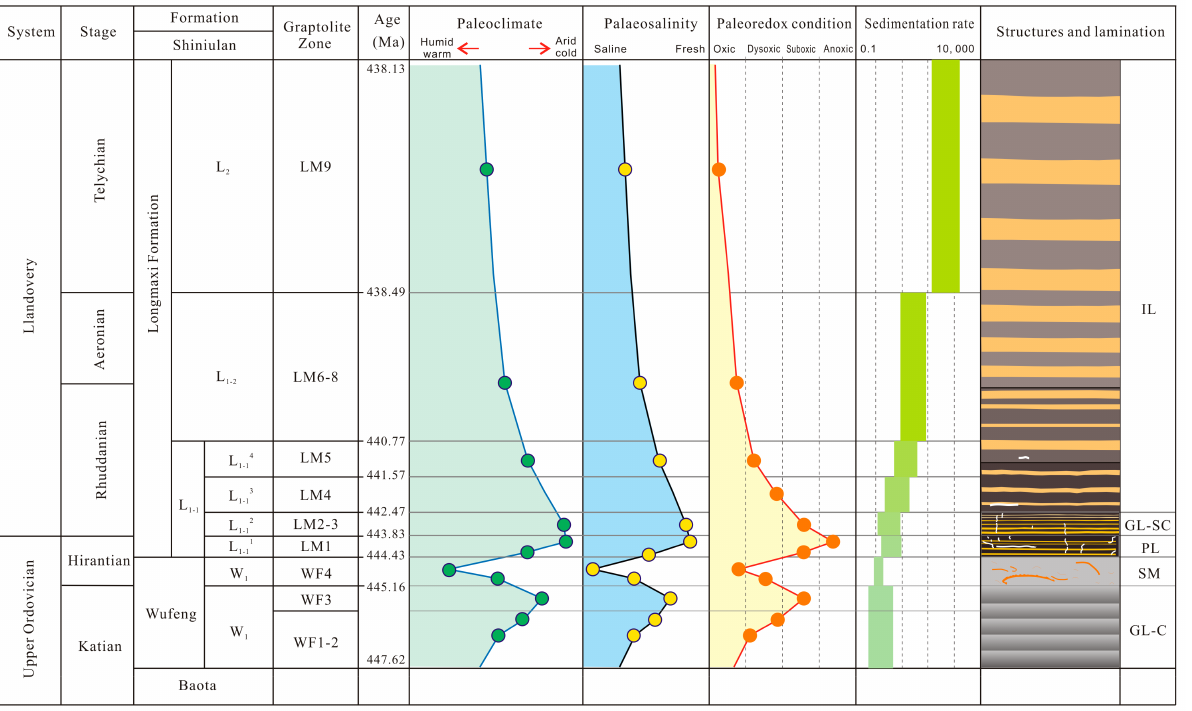
Figure 9. Vertical distribution of geochemical characters and sedimentation rate of different deposi- tional structures in the Sichuan Basin of southwestern